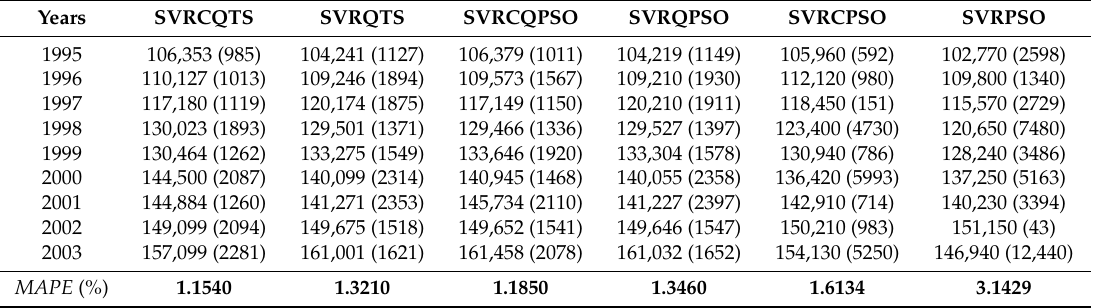
Table 5. Forecasting results (and absolute errors) of SVRCQTS, SVRQTS, and other models (unit: 10 6 Wh).